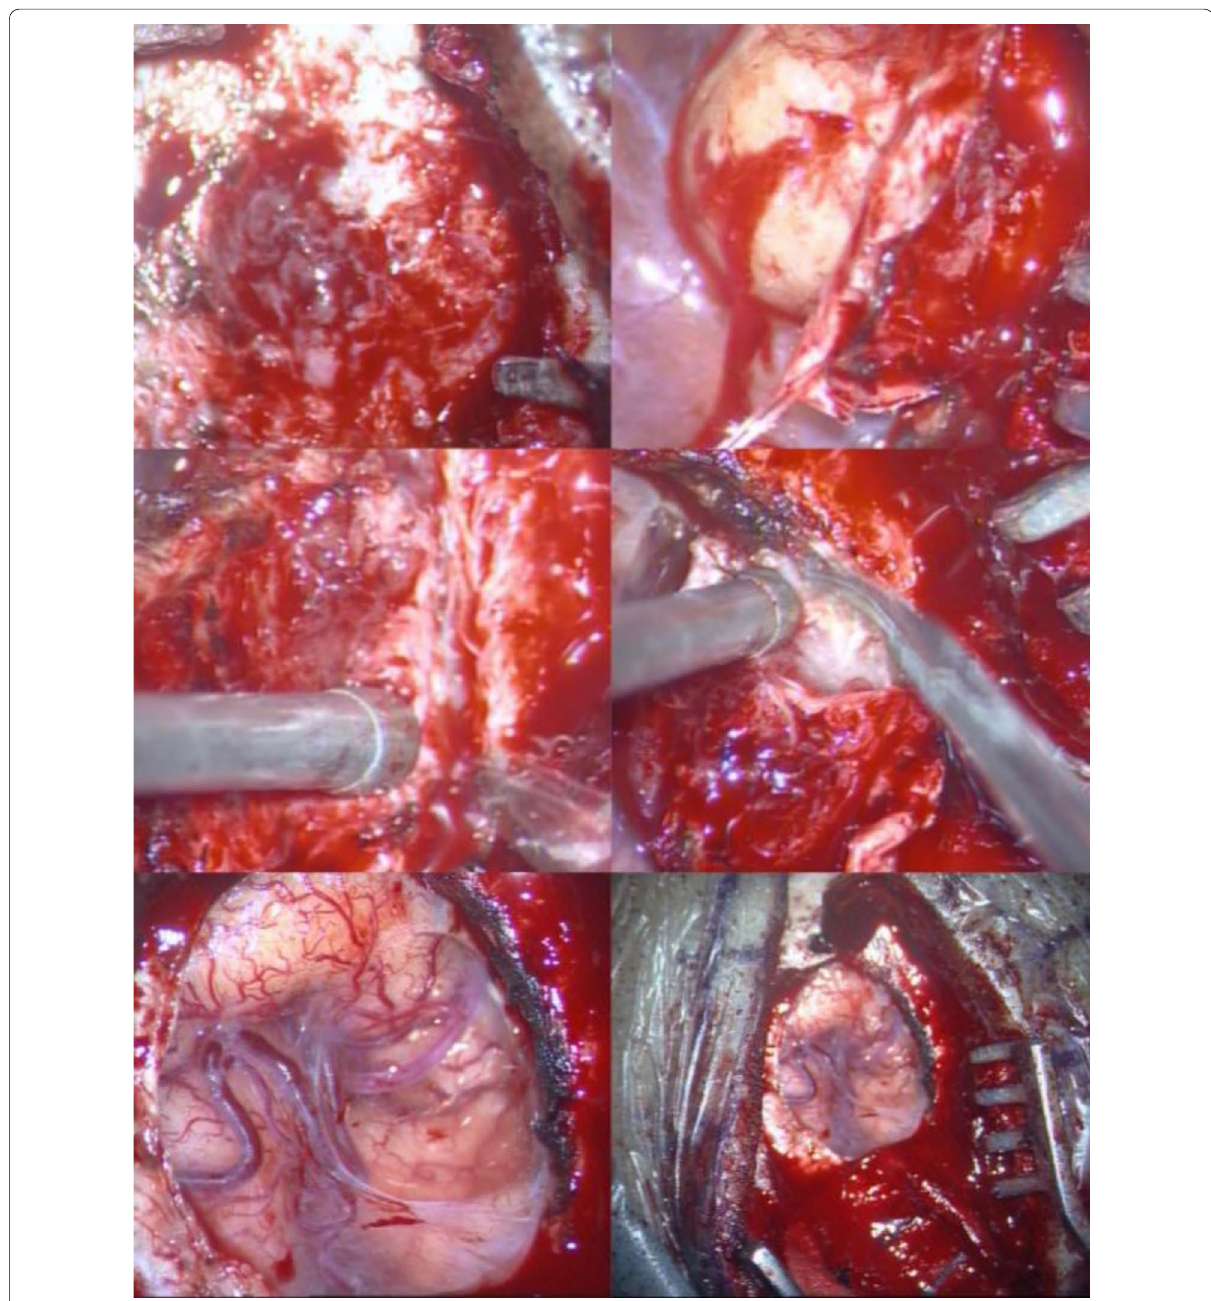
Fig. 6 Intraoperative images showing the exact location of meningioma by using the computer-aided